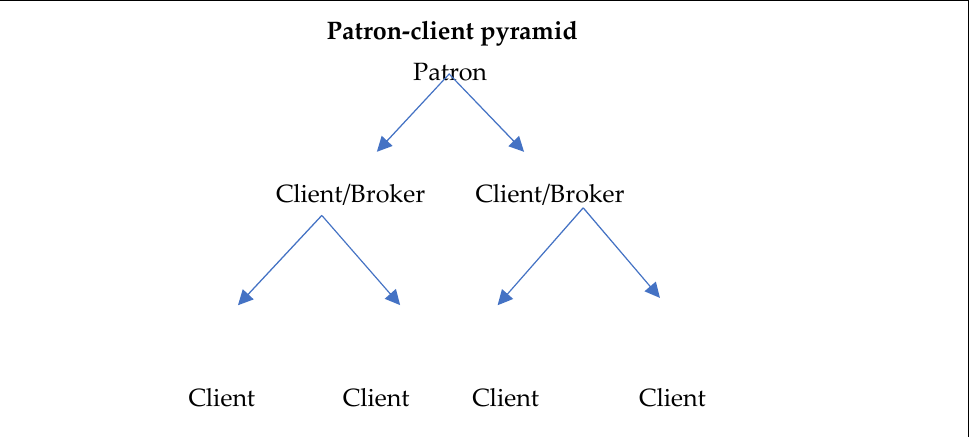
Figure 2. Patron-client pyramid.